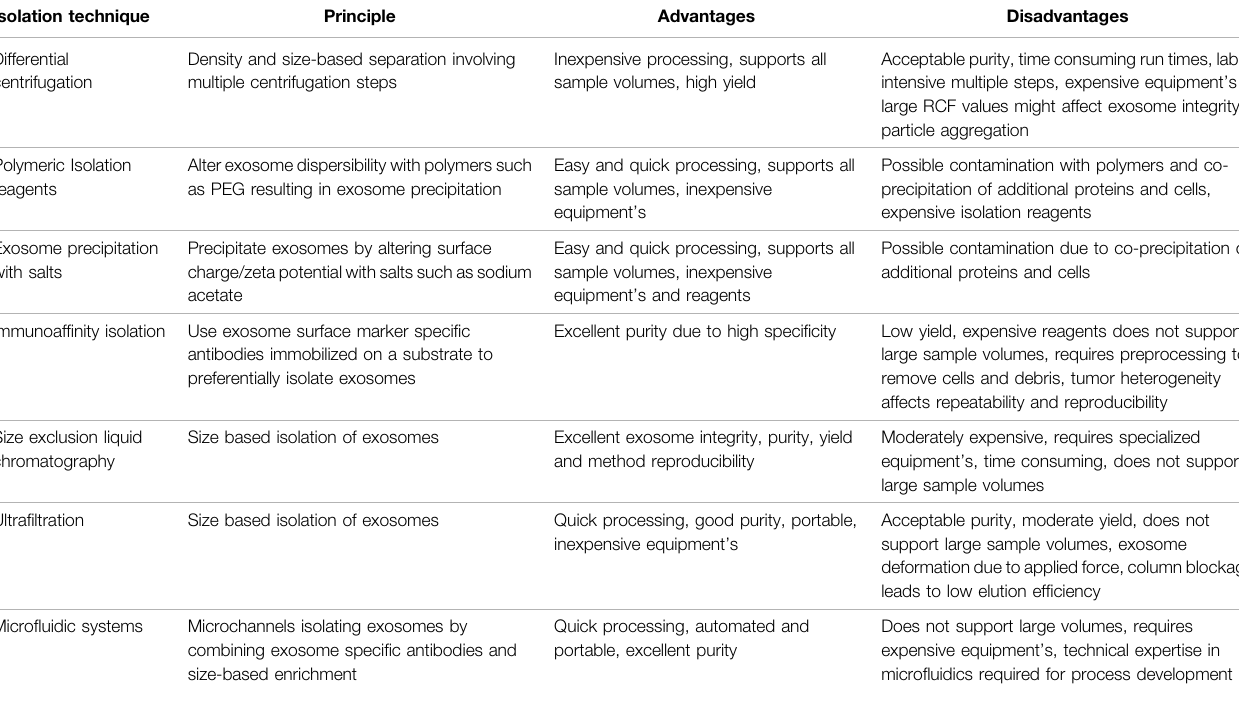
TABLE 2 | A brief summary of conventional methods for isolating exosomes with their respective advantages and disadvantages (Witwer et al., 2013; Thery et al.,